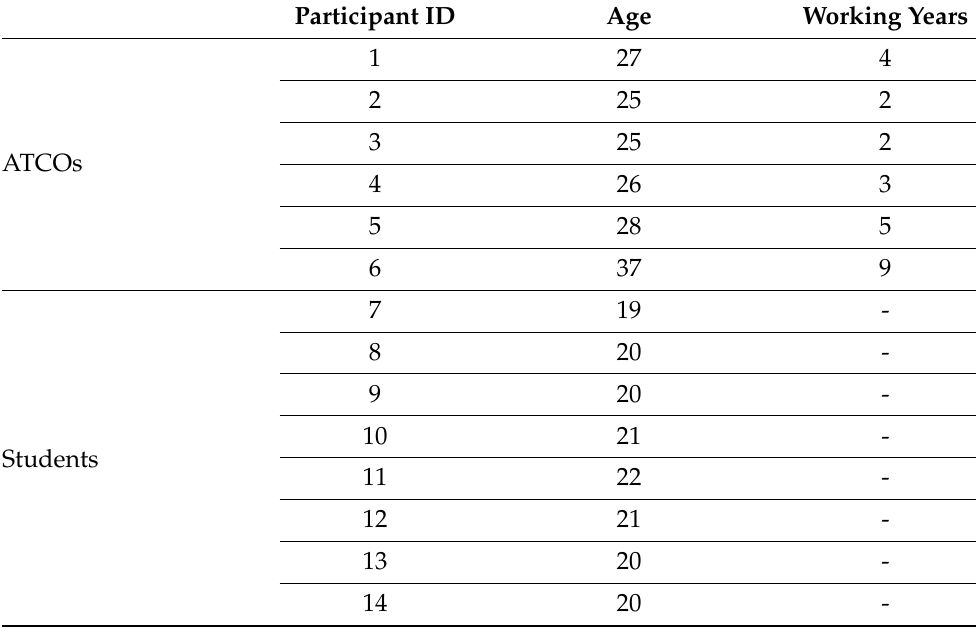
Table 2. Information of the